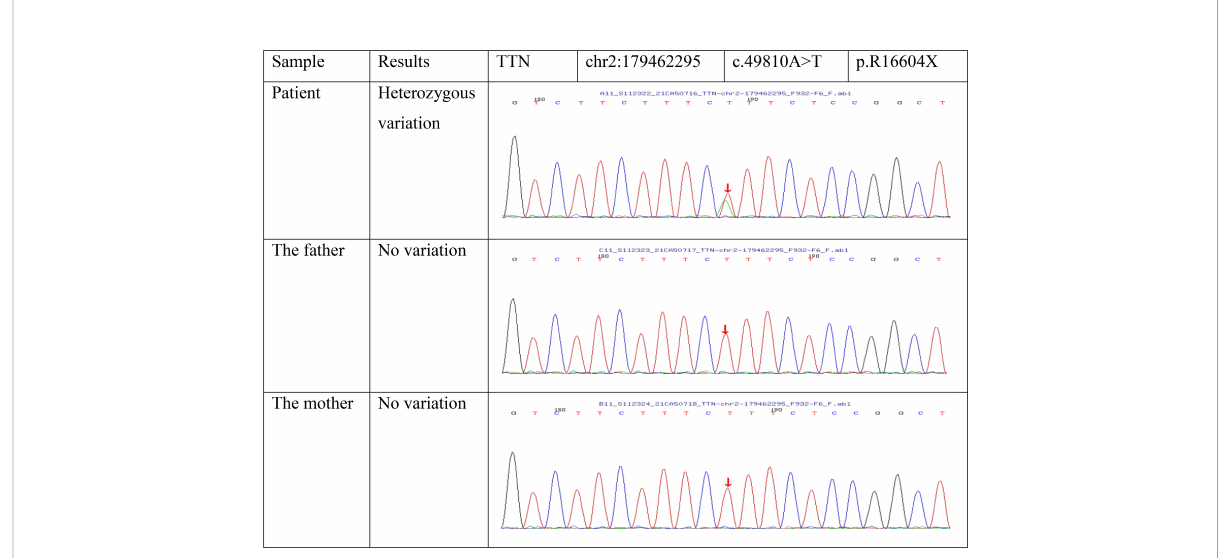
FIGURE 1 Results of family analysis of TTN gene